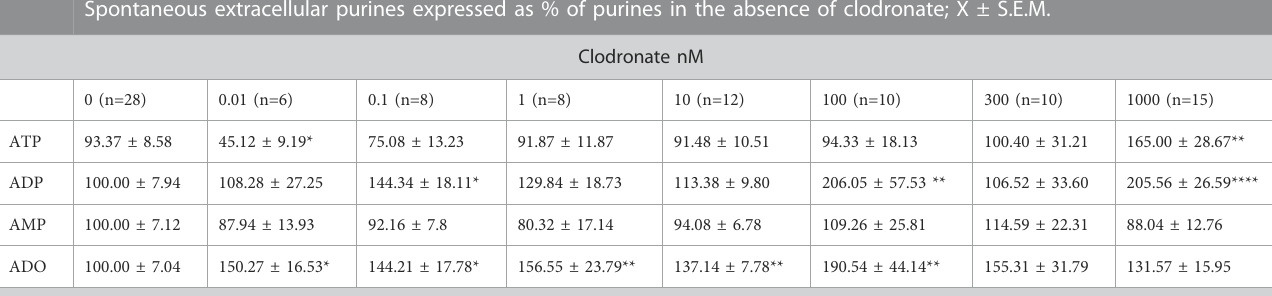
TABLE 2 Clodronate concentration-dependent effects on the spontaneous and mechanically evoked ATP/metabolites from primary cultures of endothelial cells from the rat mesentery. Spontaneous extracellular purines expressed as % of purines in the absence of clodronate; X ±